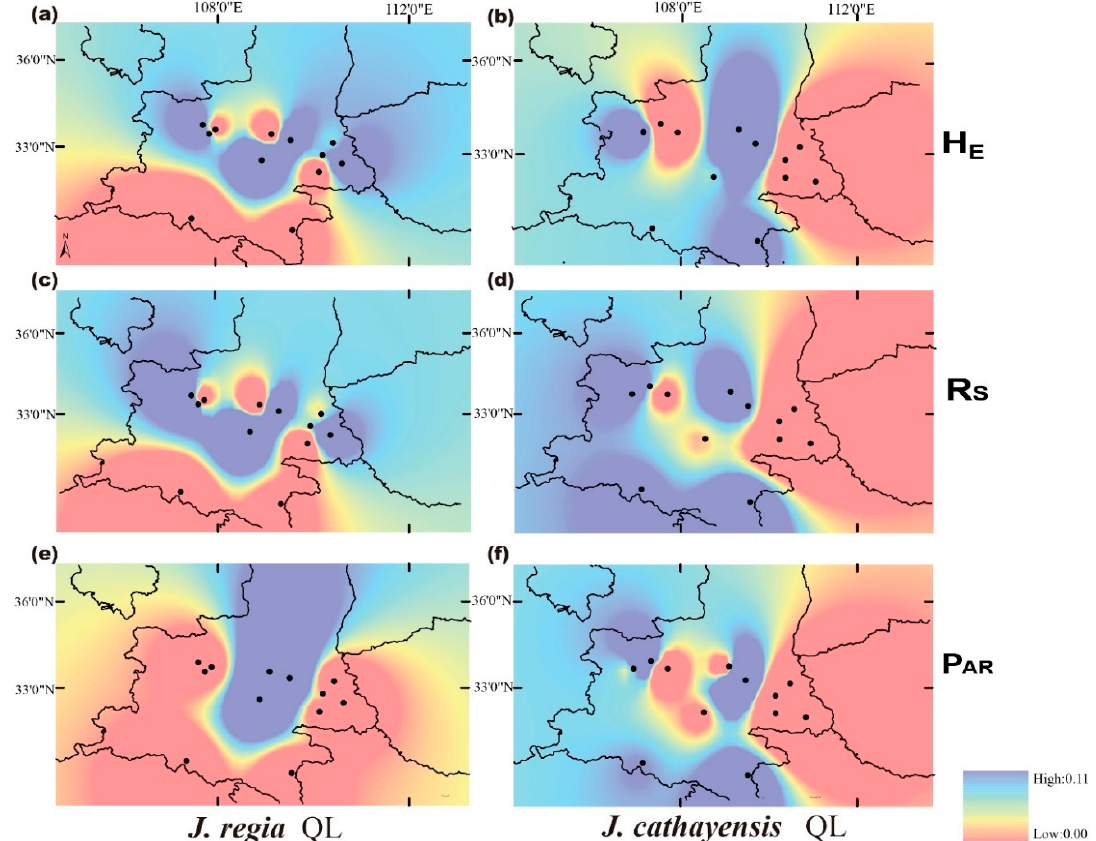
Figure 2. Inverse distance weighted (IDW) interpolation of the expected heterozygosity ( H E ), the allelic richness ( Rs ), and the private allele richness ( P AR ) for the 24 populations (black dots; 12 pairs of sympatric J. regia and J. cathayensis populations) from the the Qingling Mountains using 17 expressed sequence tag simple sequence repeat (EST-SSR) markers. The numbers of walnut populations are shown in Table 1. IDW interpolation of ( a , c , e ) expected heterozygosity ( H E ), allelic richness ( Rs ), and private allele richness ( P AR ) values of J. regia ; ( b , d , f ) expected heterozygosity ( H E ), allelic richness ( Rs ), and private allele richness ( P AR ) values of J. cathayensis .